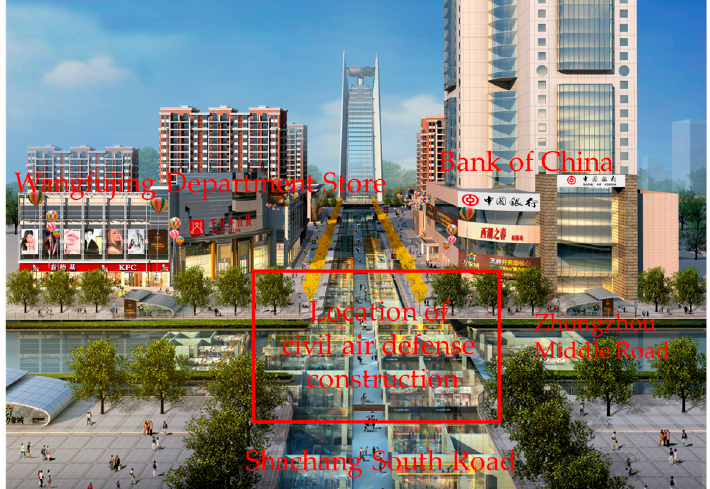
Figure 3. Schematic diagram of ground road above the measuring point [34].